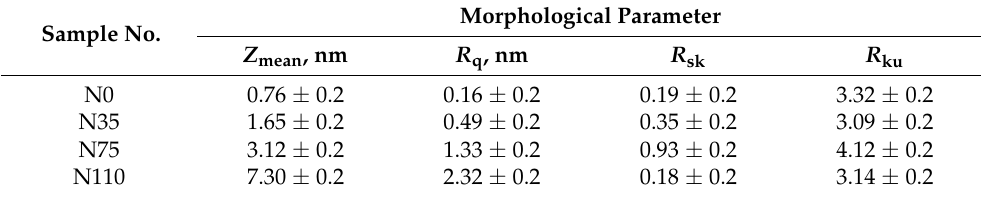
Table 1. Surface morphological parameters. Morphological Parameter Sample No. Z mean , nm R q ,